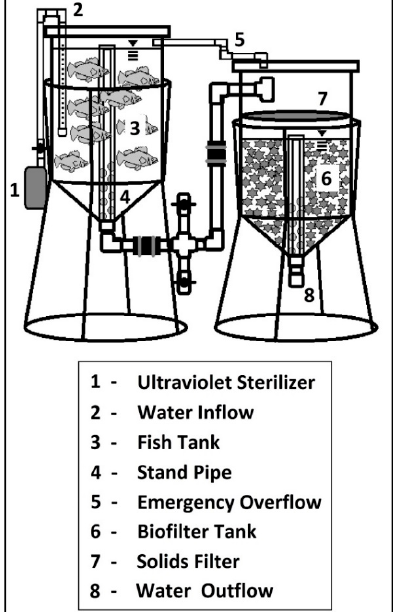
Figure 2. Diagram of the parts (i.e., UV sterilizer, water inflow, fish tank, stand pipe, emergency overflow, biofilter tank, solids filter, and water outflow) of the aquaculture unit utilized to house the Barramundi over 118 days for reproducibility of unit design.